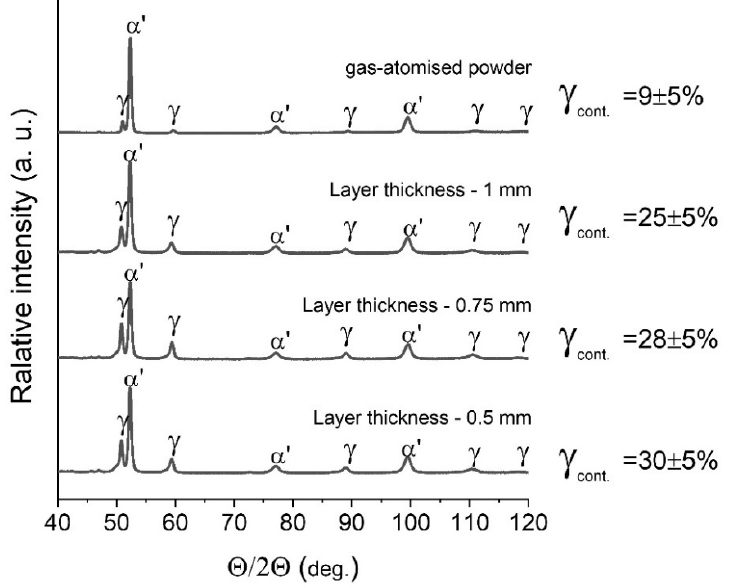
Figure 7. XRD patterns for samples manufactured with different parameters compared to the gas- atomized powder. Retained austenite content calculated with RIR method.